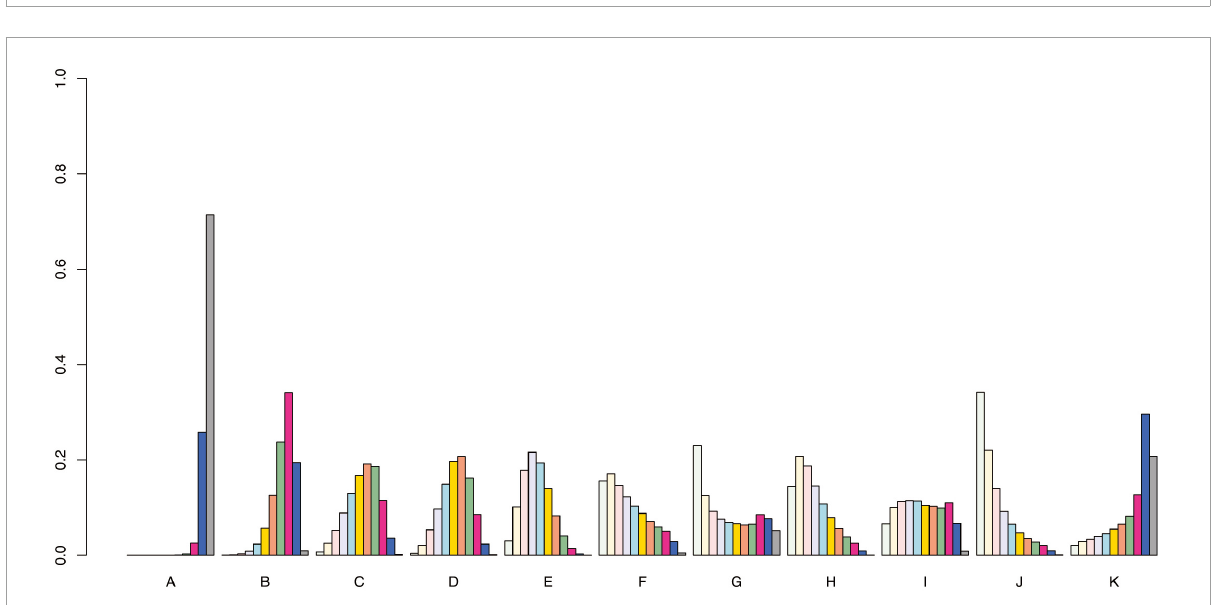
FIGURE6 Visual analog scale probability ranking diagram. A = antiepileptics; B = manual acupuncture; C = electroacupuncture; D = fire needling; E = pricking and cupping; F = Fu’s acupuncture; G = medicated thread moxibustion; H = electroacupuncture plus antiepileptics; I = fire needling plus antiepileptics; J = pricking and cupping plus antiepileptics; K = acupoint catgut embedding plus